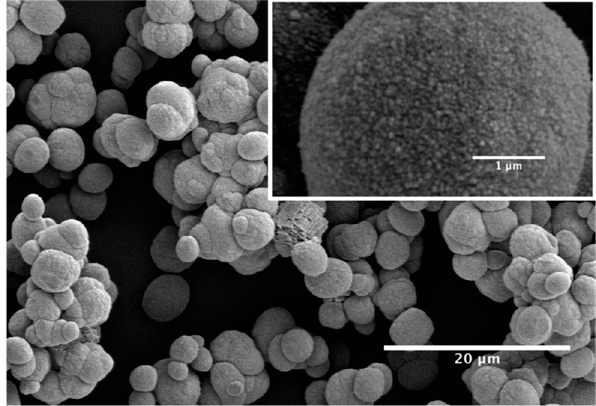
Figure 6. Vaterite at initial stage of phase transformation. Inset: Magnification of a vaterite grain demonstrating the surface roughness consisting of ~100 nm spheres on the 2–5 µm large vaterite grains.